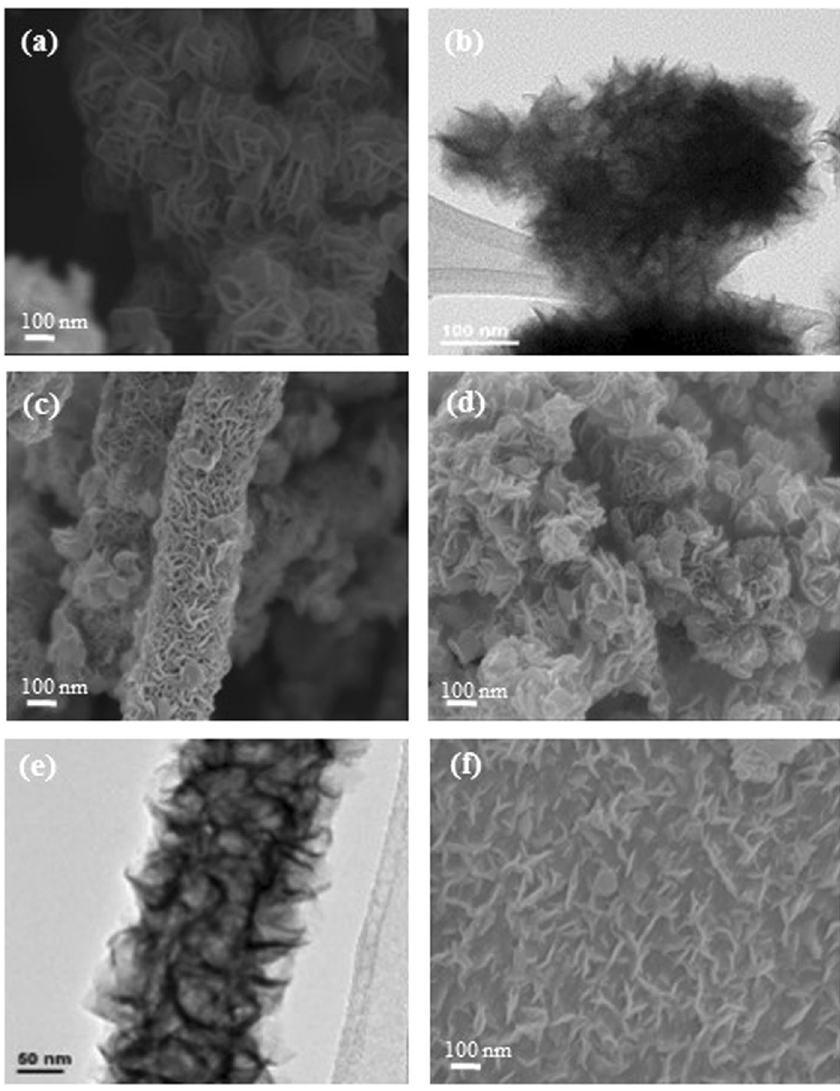
Figure 3. ( a , b ) SEM image and HR-TEM image of bare MoS 2 , ( c , d ) SEM images of MoS 2 on the fiber surface and by the fiber for MPR25-2, respectively, ( e ) TEM image of MoS 2 on the fiber surface for MPR25-3, and ( f ) SEM image of MoS 2 on the RGO surface.